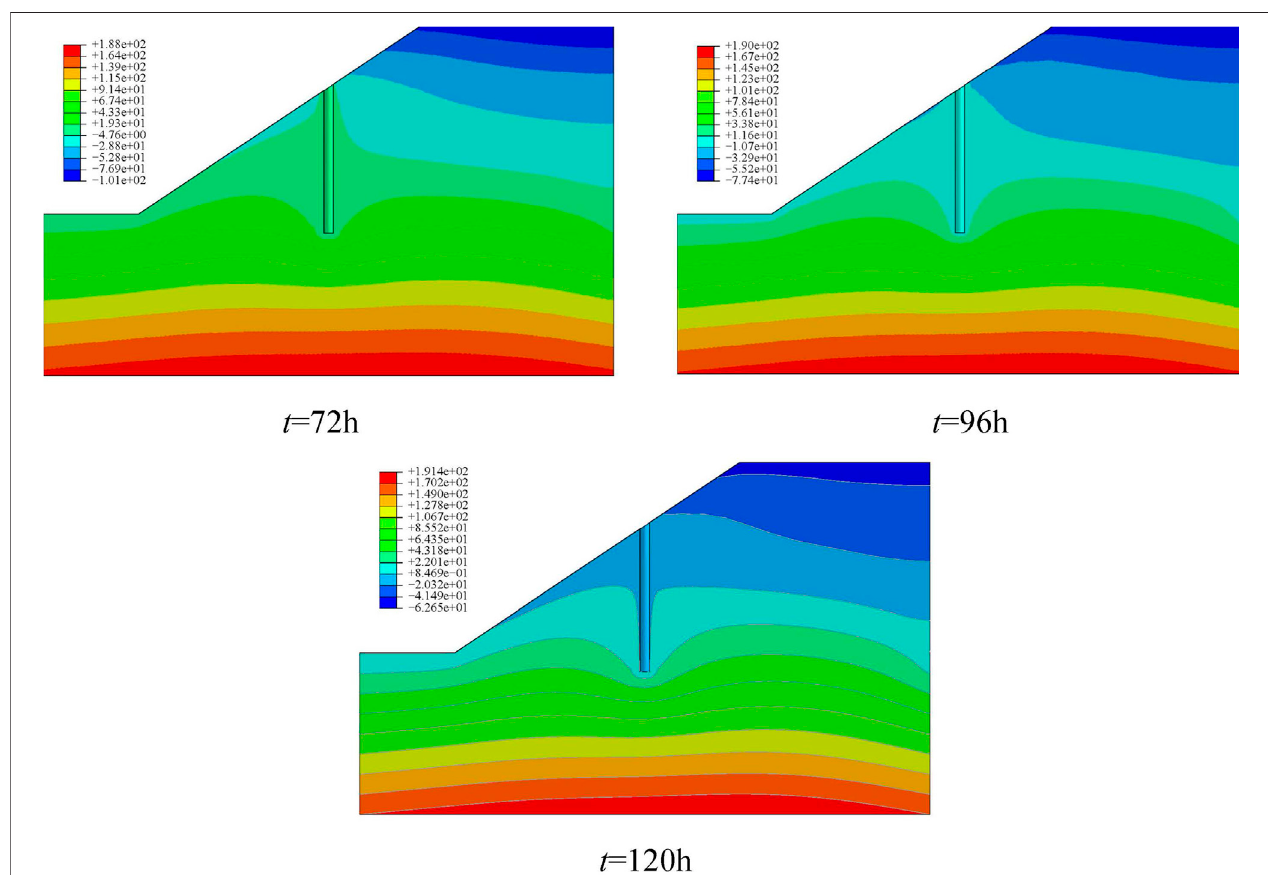
FIGURE 5 | Pore pressure distribution map of the slope after rain in different rainfall duration.